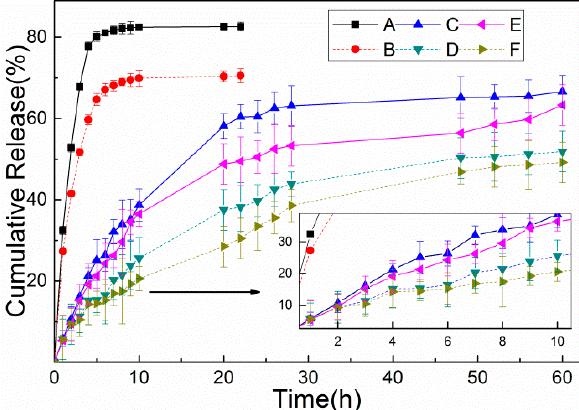
Figure 7. Free Doxorubicin Hydrochloride (DOX) solution was assayed as a control in ( A ) pH 5.3 and ( B ) pH 7.4 PBS. Accumulative releases of DOX from LHNPs@DOX in ( E ) pH 5.3 and ( F ) pH 7.4 PBS. And In vitro release of DOX from FA-MLHNPs@DOX in ( E ) pH 5.5 and ( F ) pH 7.4 PBS.